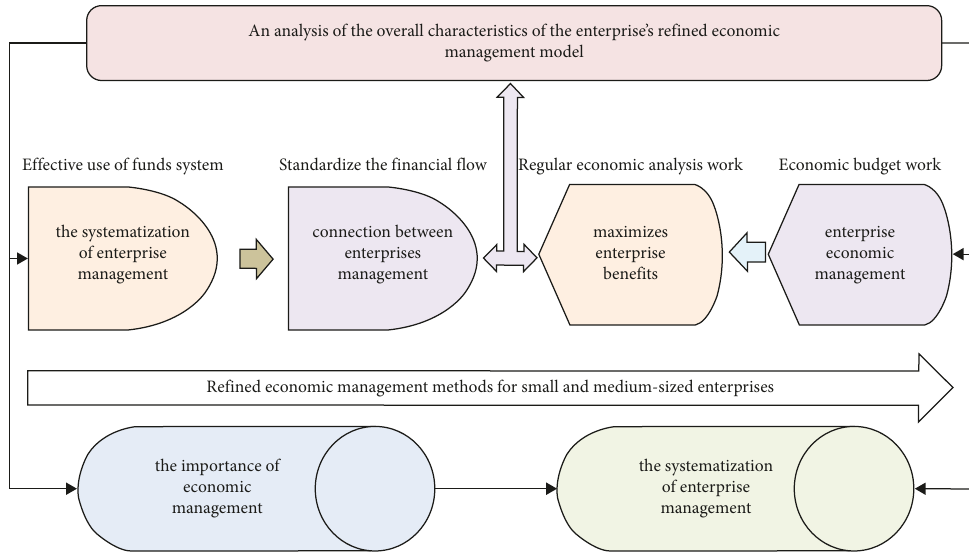
Figure 3: The analysis of the overall characteristics of the enterprise’s refined economic management model.